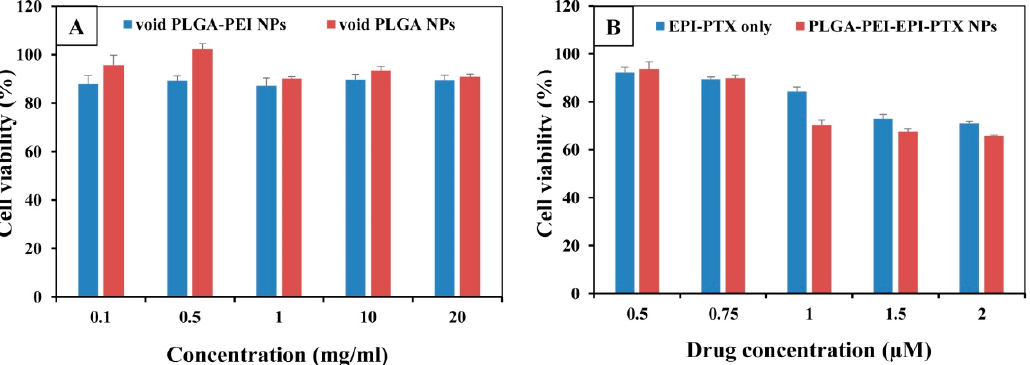
Figure 9. Cell viability in HEK 293 normal cell lines as determined through MTT assay. The cells were treated with ( A ) void PLGA nanoparticles and with ( B ) PLGA-PEI-EPI-PTX NPs. Data are shown as mean ± SD (n = 3).